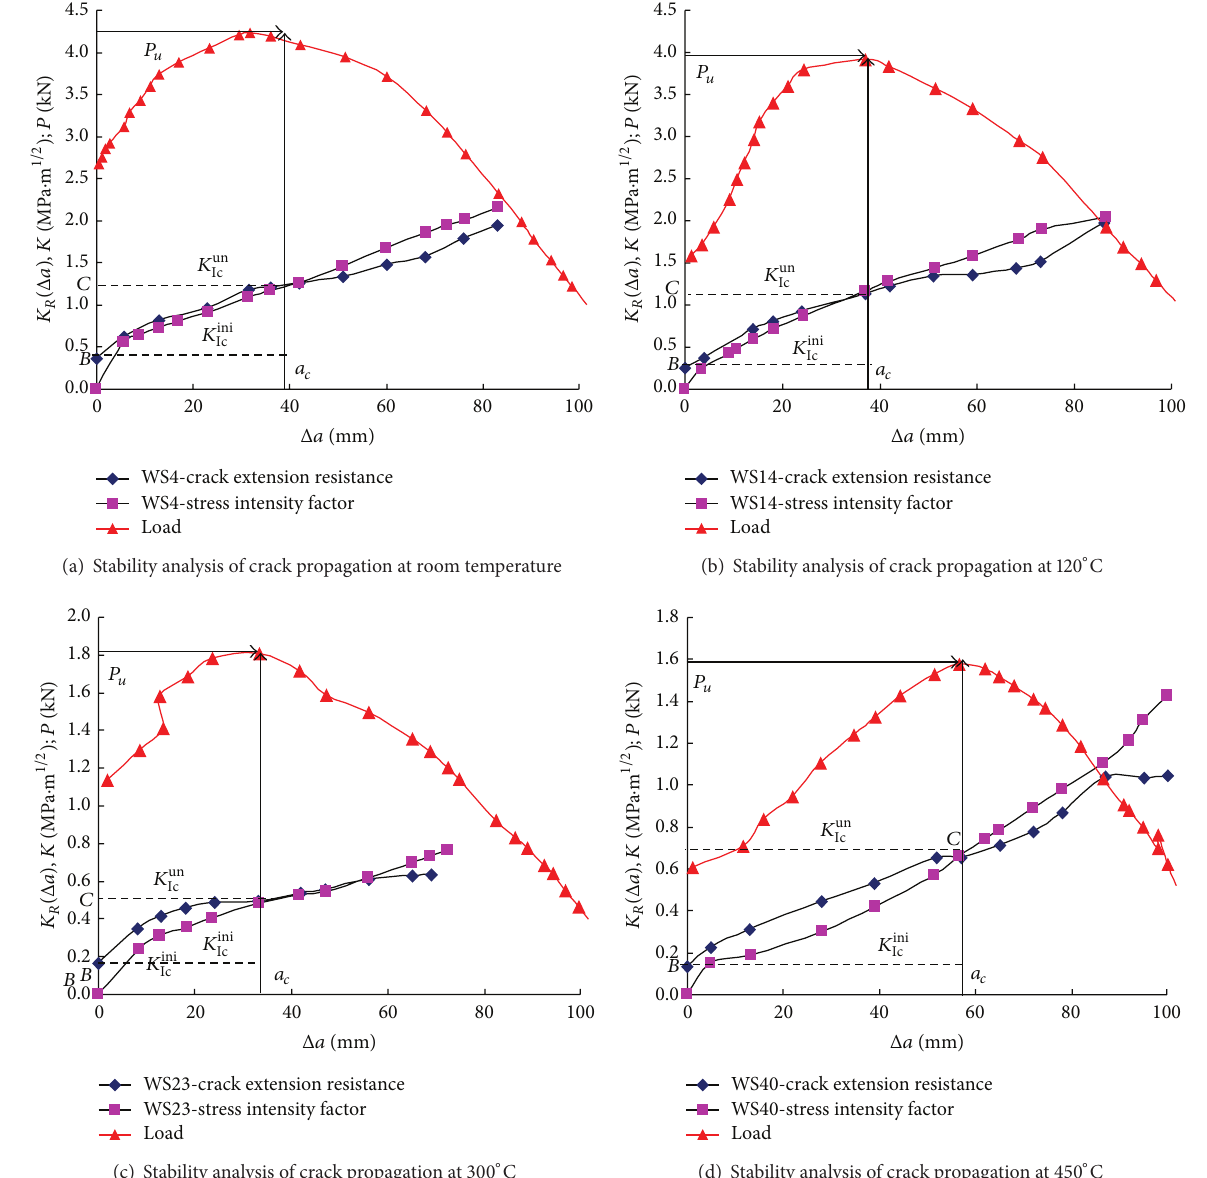
(d) Stability analysis of crack propagation at 450 ∘ C Figure 11: Stability analysis of crack propagation of various